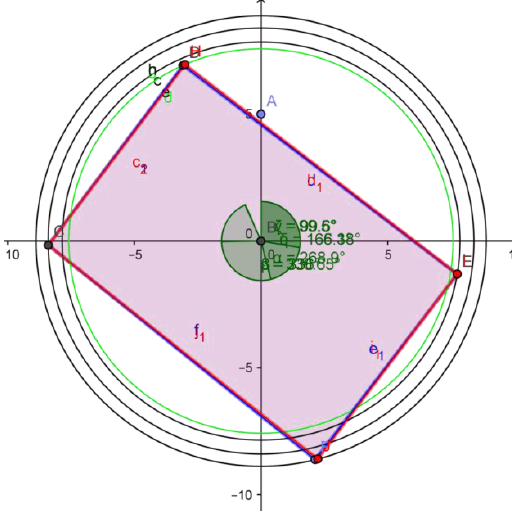
Figure 8: The reconstruction of Room 1 from original rangefinder measurements (red) and interval valued homotopy continuation calibration of horizontal angles measurements